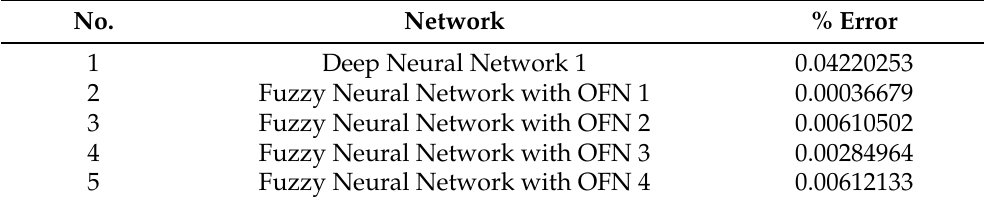
Table 1. Network error.